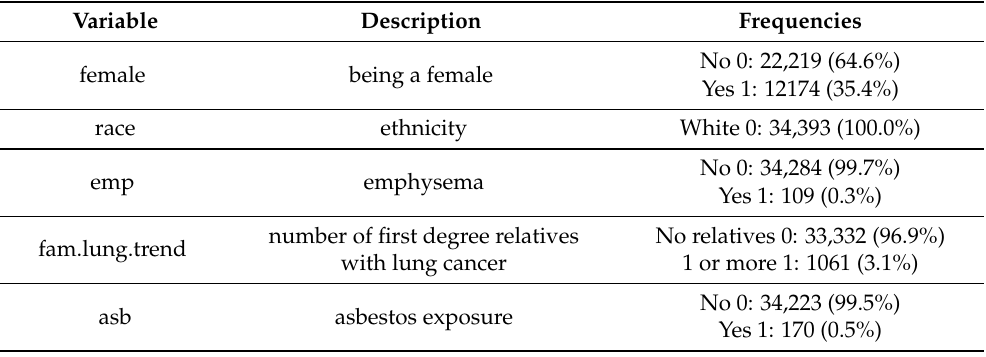
Table 4. Descriptive statistics of categorical predictors available in the Domestic Lung Cancer Database.